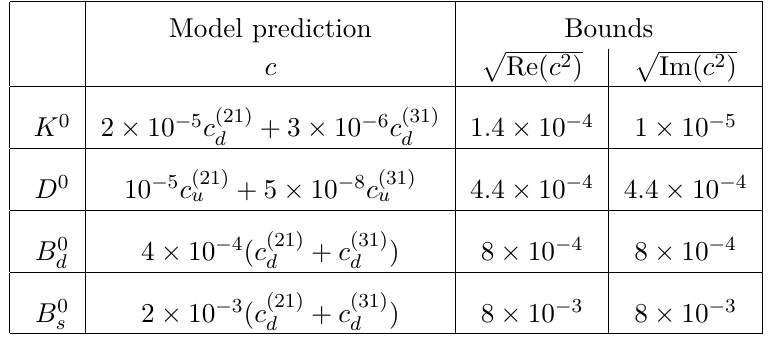
Table 2 . Wilson coefficients for meson mixing. Defining the Wilson coefficient as C = ( c/ TeV) 2 an taking f = 1 TeV, the second column shows the estimates for c in the model, the third and fourth columns show the bounds on the real and imaginary parts of these coefficients